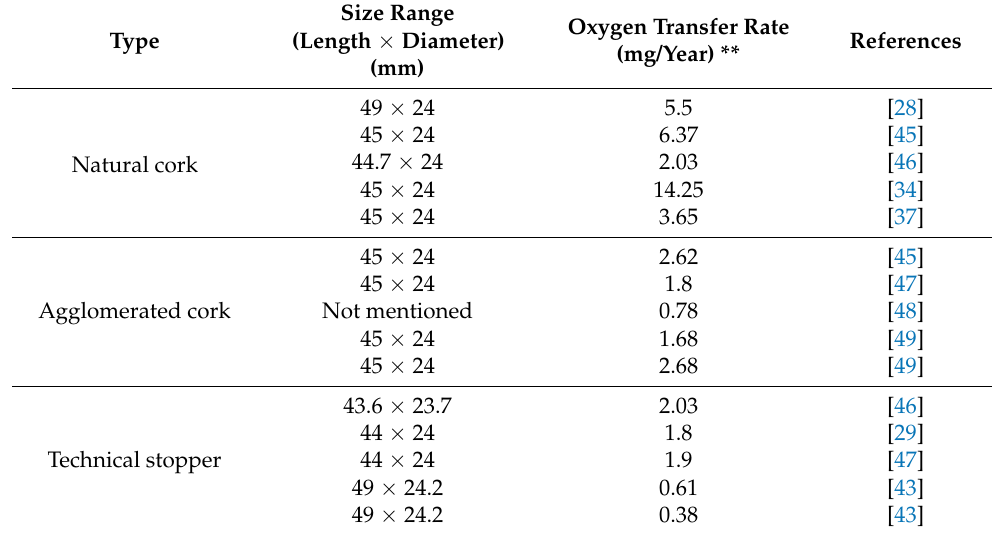
Table 1. Mean oxygen transfer rate of several types of stoppers